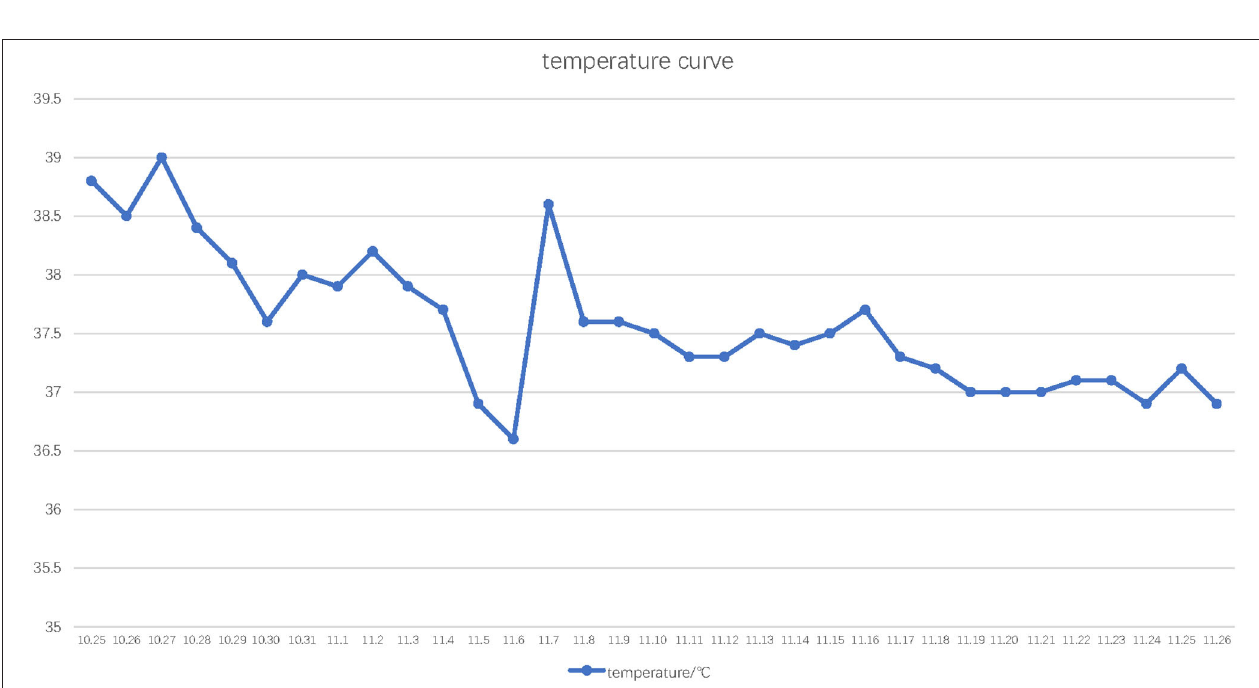
FIGURE 2 | Temperature curve. The horizontal axis indicates the date and the vertical axis indicates highest daily ear temperature.